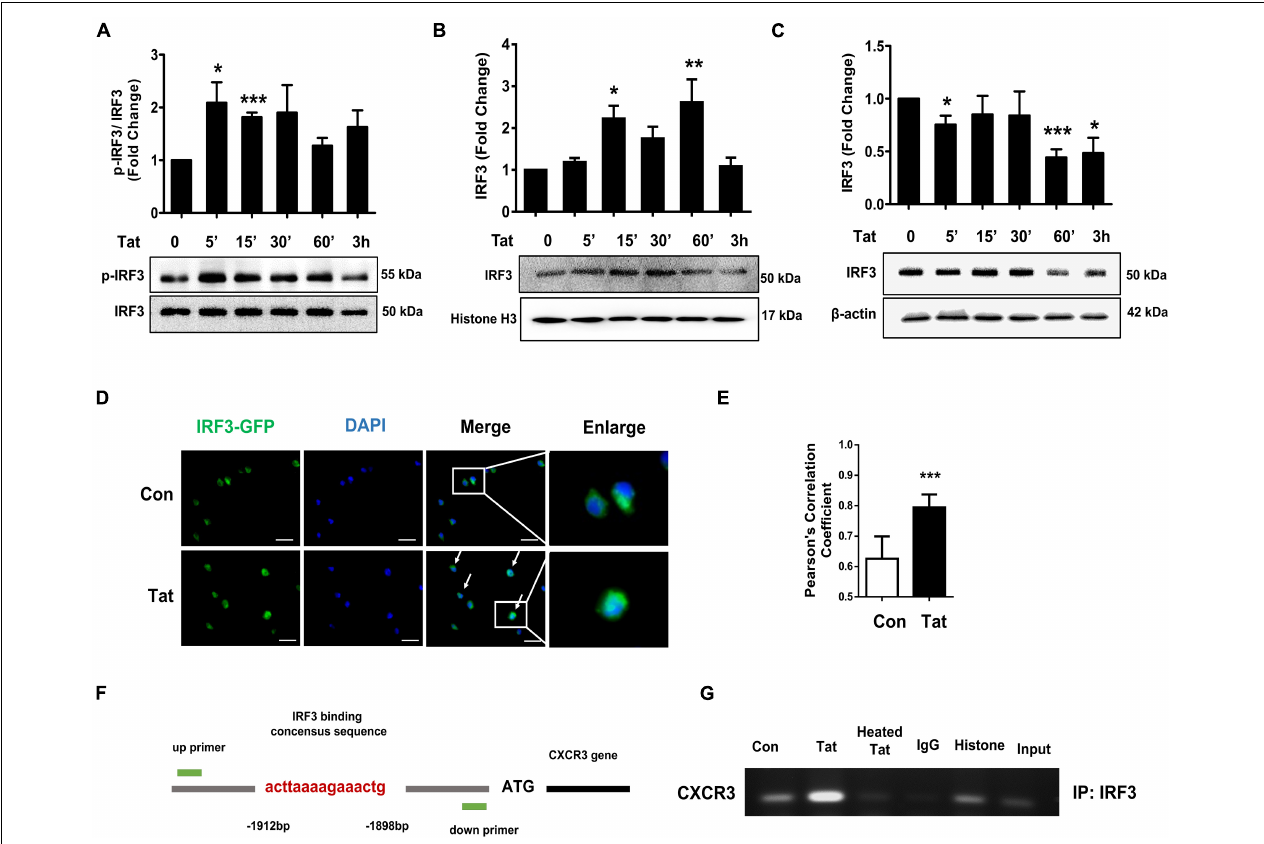
FIGURE 5 | HIV Tat-mediated IRF3 phosphorylation and nuclear translocation. (A) Representative Western blot and quantification of p-IRF3, IRF3 in the cell lysates from human monocytes exposed to HIV Tat for various time points (5 min – 3 h). N = 3. (B) Representative Western blot and quantification of IRF3 in the nuclear cell lysates from human monocytes exposed to HIV Tat for various time points (5 min to 3 h). N = 4. (C) Representative Western blot and quantification of IRF3 in the cytoplasmic cell lysates from human monocytes exposed to HIV Tat for various time points (5 min to 3 h). N = 4. (D) Representative images of human monocytes transfected with IRF3-GFP plasmid, followed by HIV Tat exposure for 15 min. Scale bars: 20 µ m. White arrow, IRF3 nuclear translocated cells. (E) Quantification of IRF3 nuclear translocation (Student’s t -test). N = 3. (F) Schematic illustration of IRF3 binding sequence on the promoter region of CXCR3. (G) ChIP assay demonstrating HIV Tat-mediated binding of IRF3 to the CXCR3 promoter. One-way ANOVA with post hoc test. All data are presented as mean ± SD of three or four individual experiments (Biological replicates). * p < 0.05 versus control group; ** p < 0.01 versus control group; *** p < 0.001 versus control